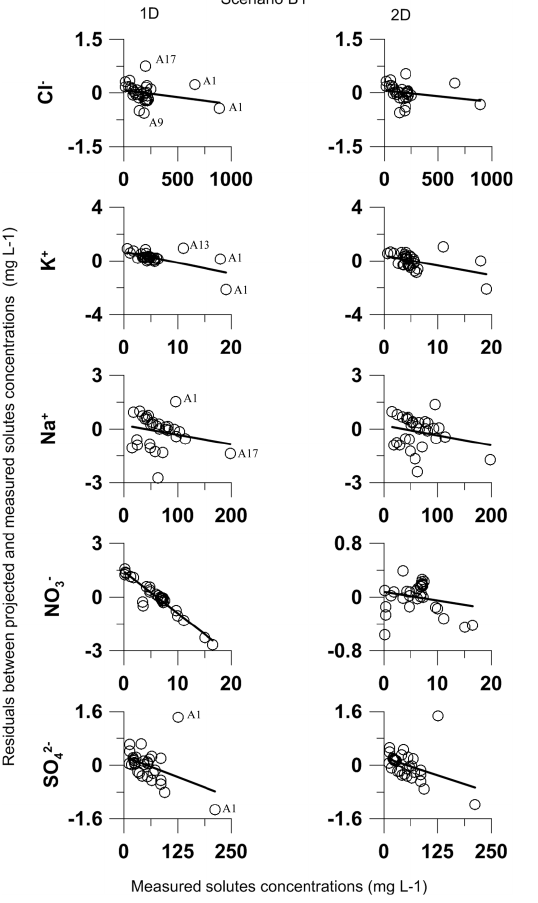
Fig. 6a. Plot of residuals versus original concentrations of solutes and stable isotopes for wet and dry seasons from the 1-D mixing space and 2-D mixing spaces for Scenario B1 (outliers are identified in the plots).